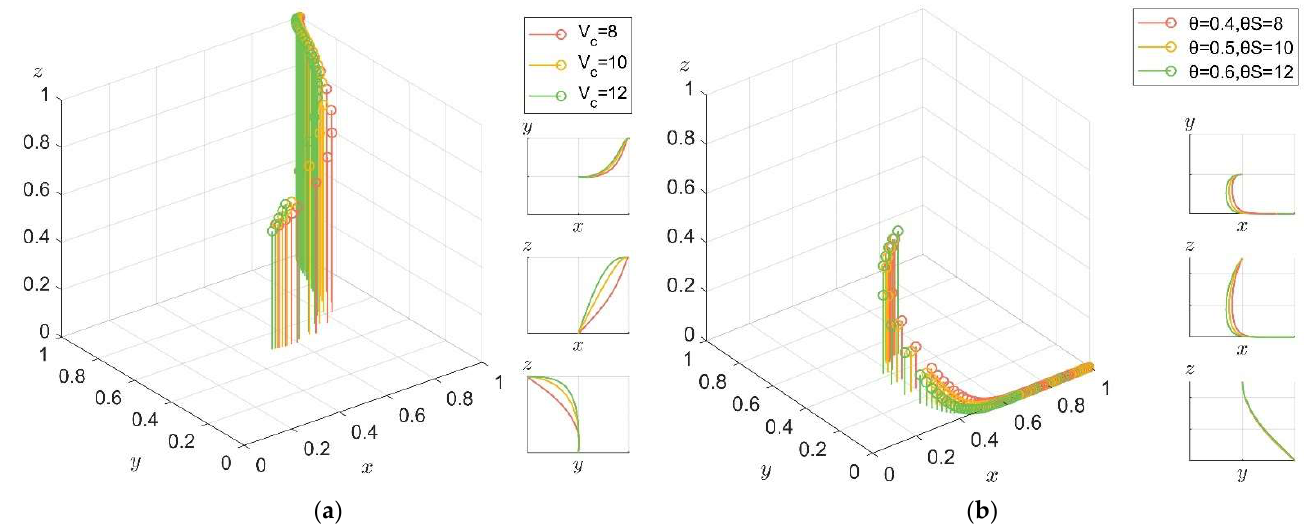
Figure 9. Evolution path of system under different product values and government subsidies. ( a ) Under different product values. ( b ) Under different government subsidies.